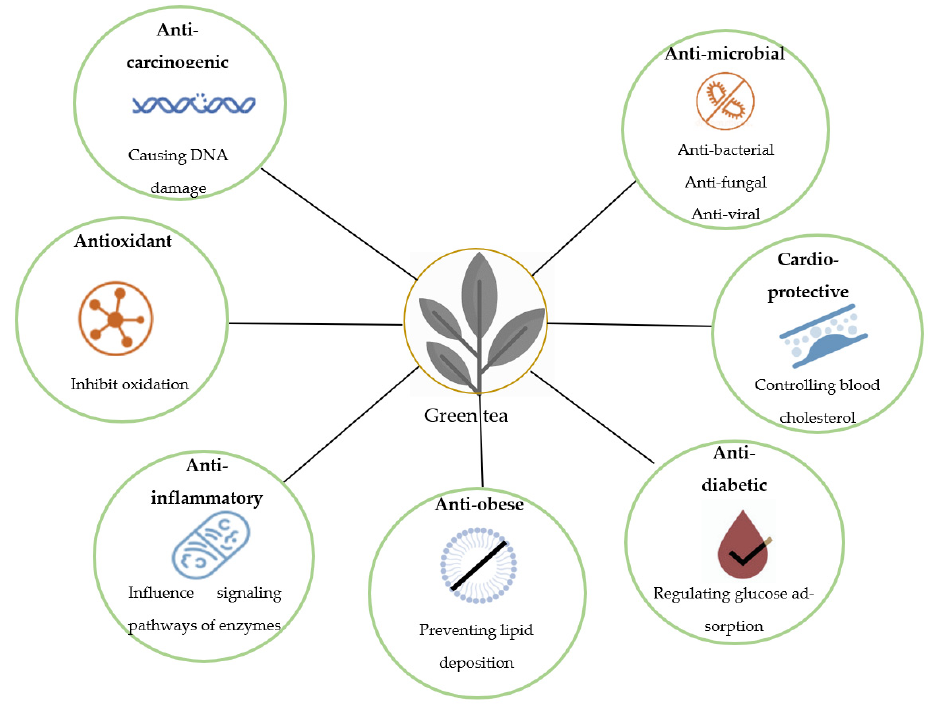
Figure 2. Prime health benefits of green tea .